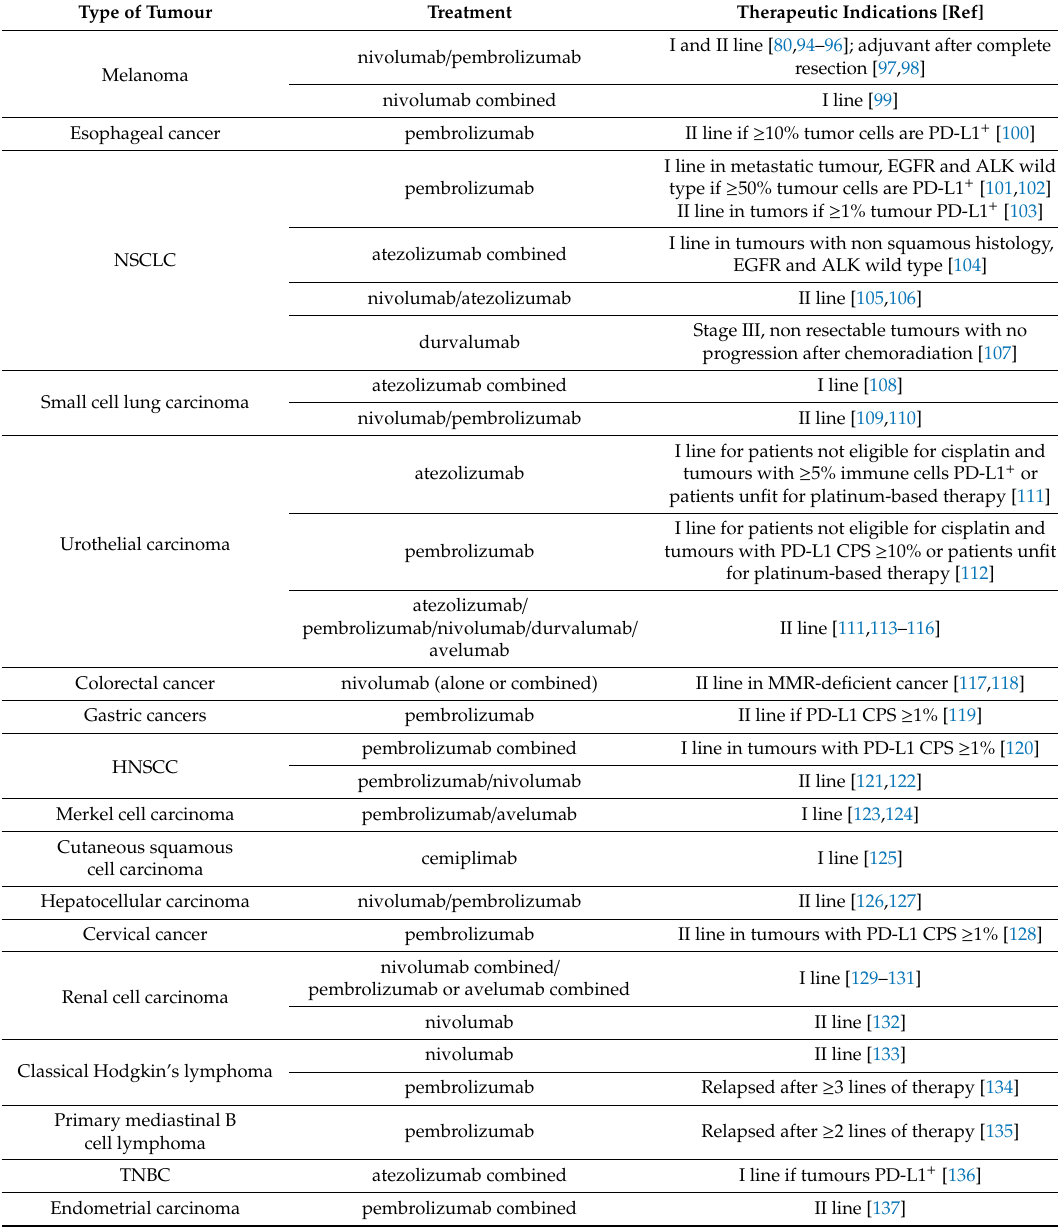
Table 2. Clinical indications for anti-PD-(L)1 immunotherapy in